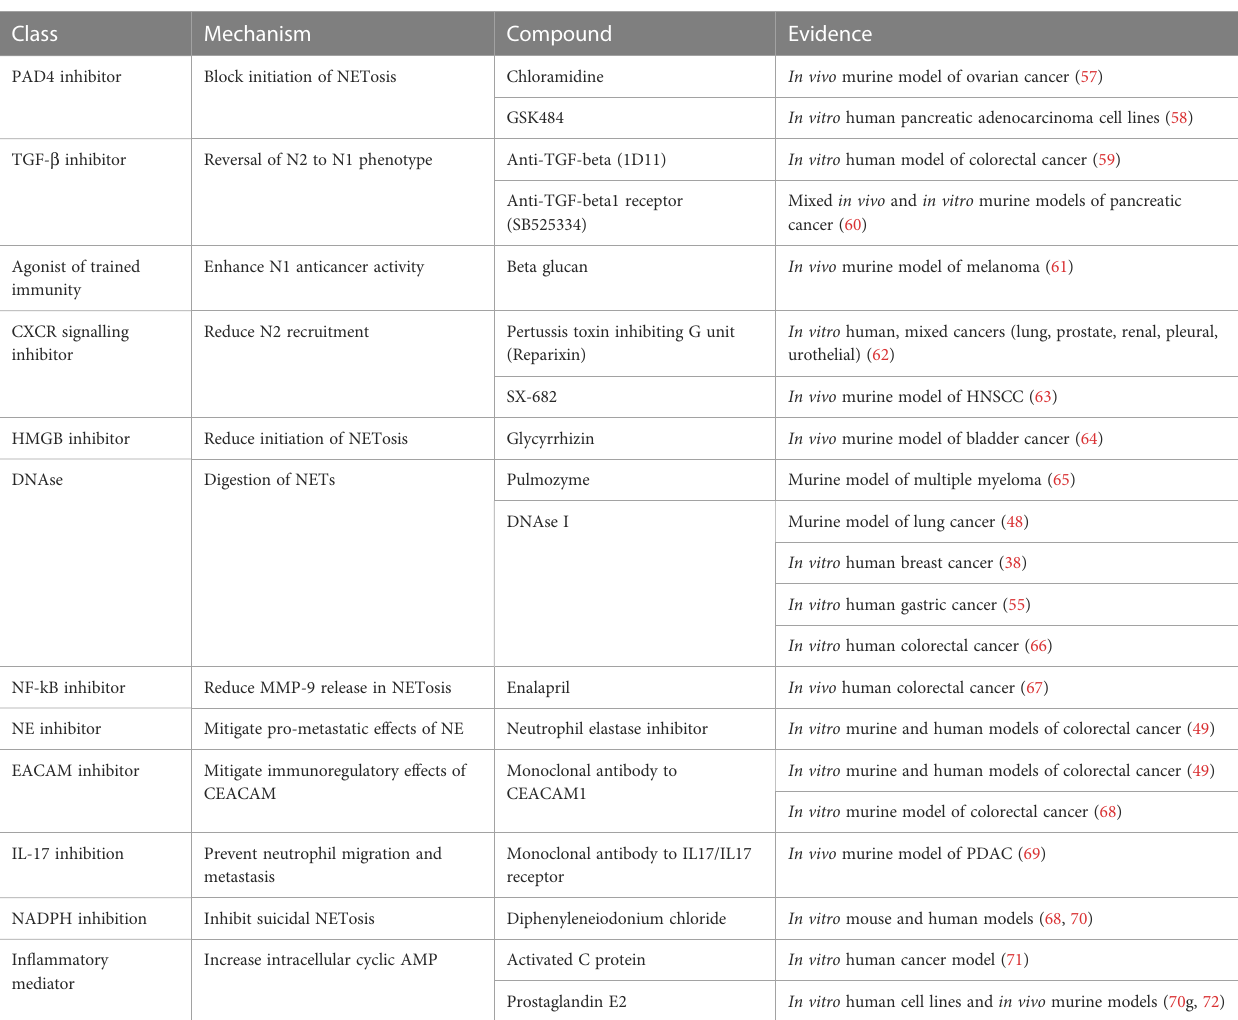
TABLE 1 Potential anti-N2 and anti-neutrophil extracellular trap (NET) therapeutics and evidence.